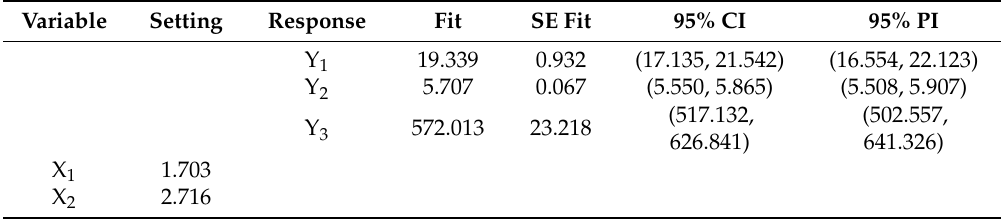
Table 6. Multiple response prediction.